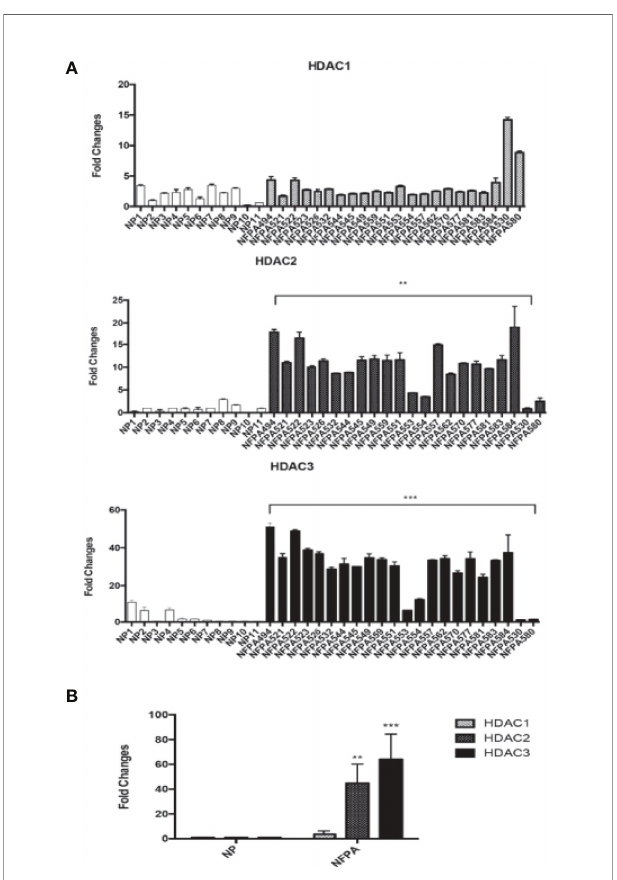
FIGURE 1 | HDAC1, 2, and HDAC3 mRNA expression in human NFPAs. (A) HDAC1 (Upper Panel), HDAC 2 (Middle Panel), and HDAC 3 (Bottom Panel) RNA expression were determined by qRT-PCR in 22 non-functioning pituitary adenomas. (B) The average expression levels of HDAC1, 2, and 3 mRNA in NFPAs compared to the average level in the normal pituitaries. Fold changes were determined by comparing the HDAC levels in tumors with that in normal pituitaries (NP, n = 11), which was set as 1. NFPA, non-functioning pituitary adenoma; **P < 0.001; ***P <